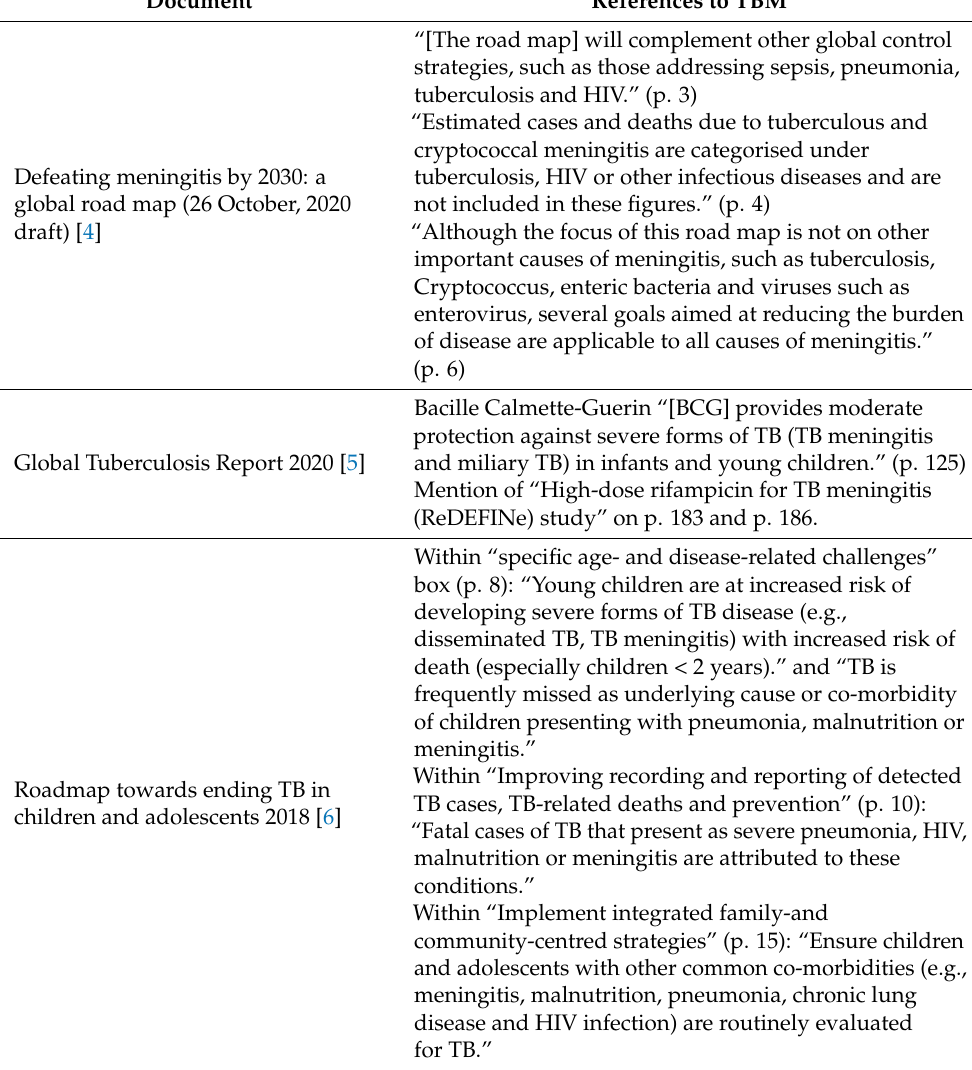
Table 1. Specific reference to tuberculous meningitis in the main text of recent key World Health Organization policy documents for either tuberculosis or meningitis